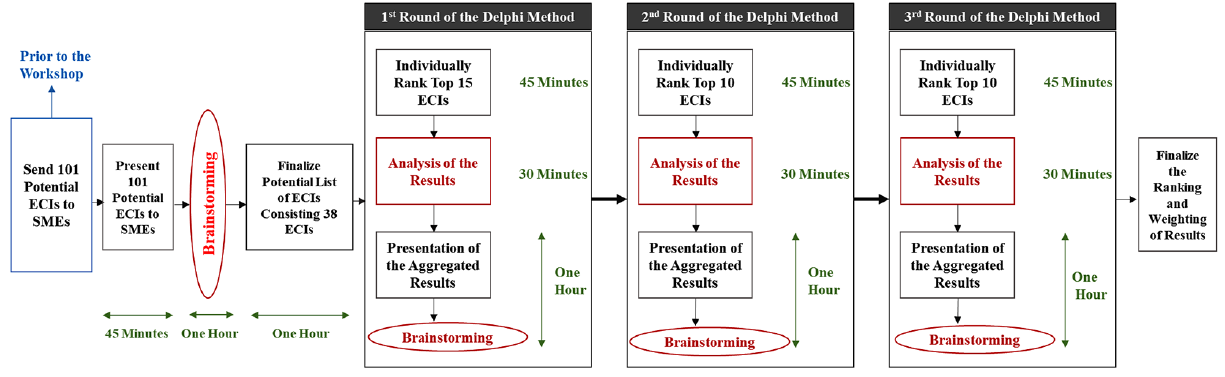
Figure 2. Procedure of the Delphi